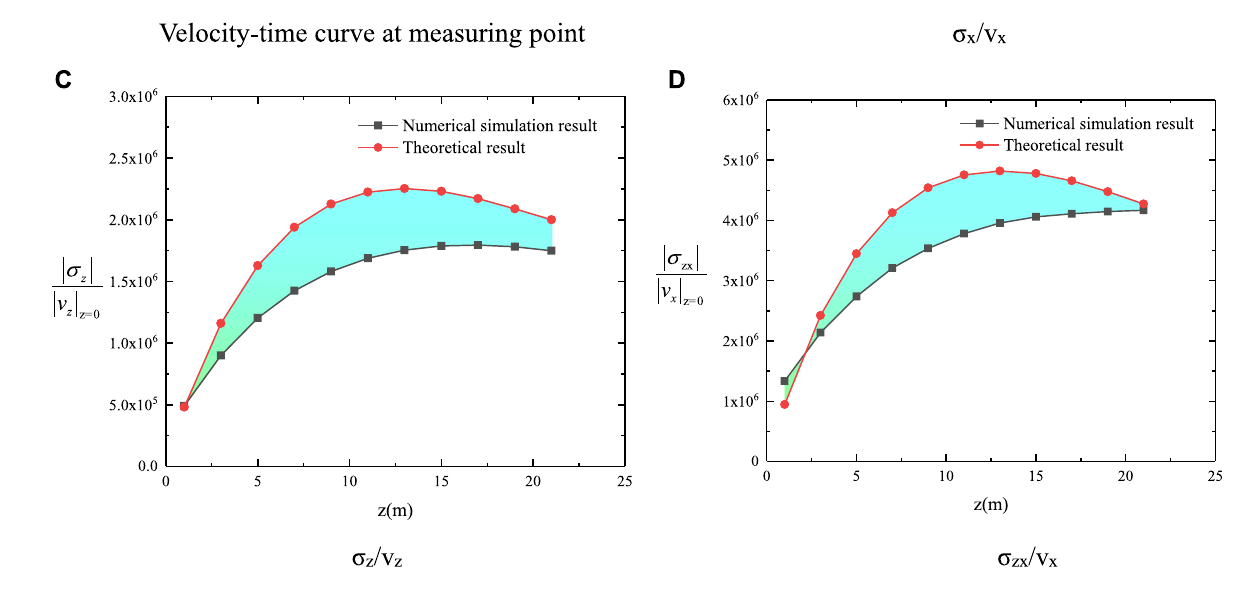
FIGURE 3 Calculation results of case 1 (A) Velocity-time curve at measuring point (B) σ x /v x (C) σ z /v z (D) σ zx /v x .